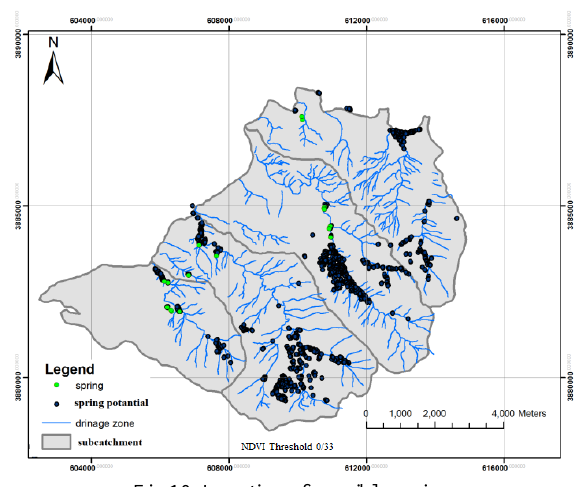
Fig 10. Location of possible springs